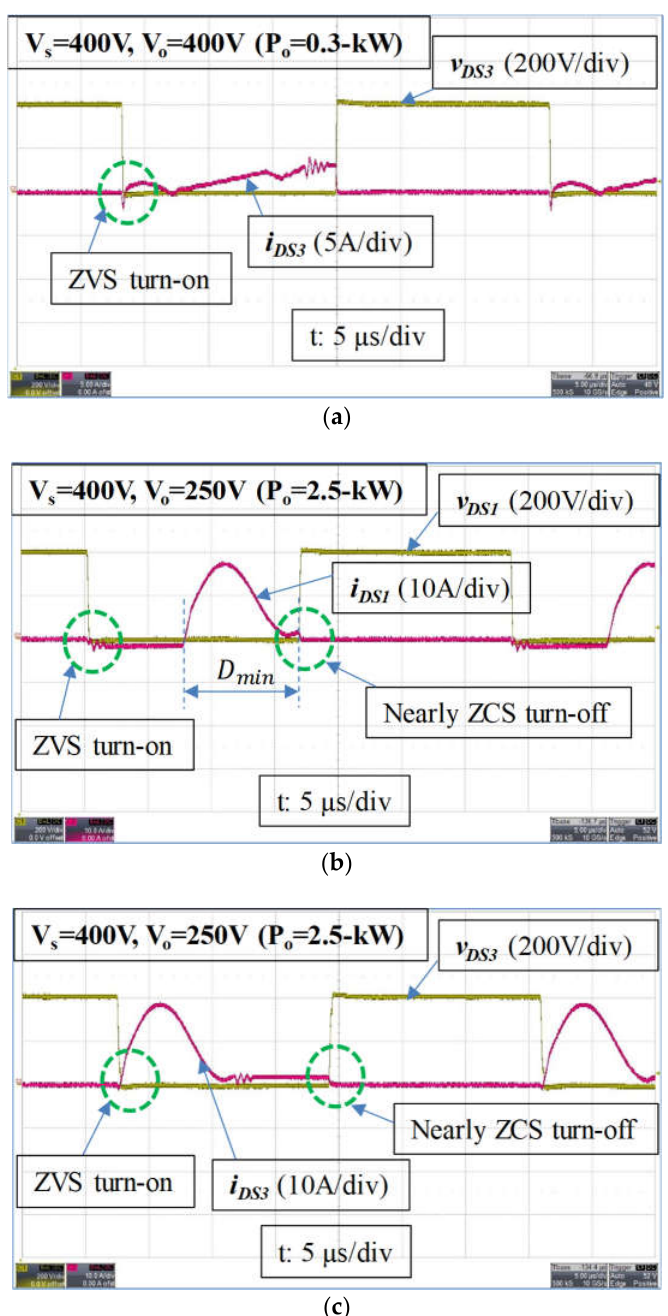
Figure 12. Experimental waveforms of the proposed converter at light load and at minimum output voltage. ( a ) Voltage and current waveforms of the lagging switch, S 3 , at light load (0.3 kW); ( b ) voltage and current waveforms of the leading switch, S 1 , at minimum output voltage (250 V); ( c ) voltage and current waveforms of the lagging switch, S 3 , at minimum output voltage (250